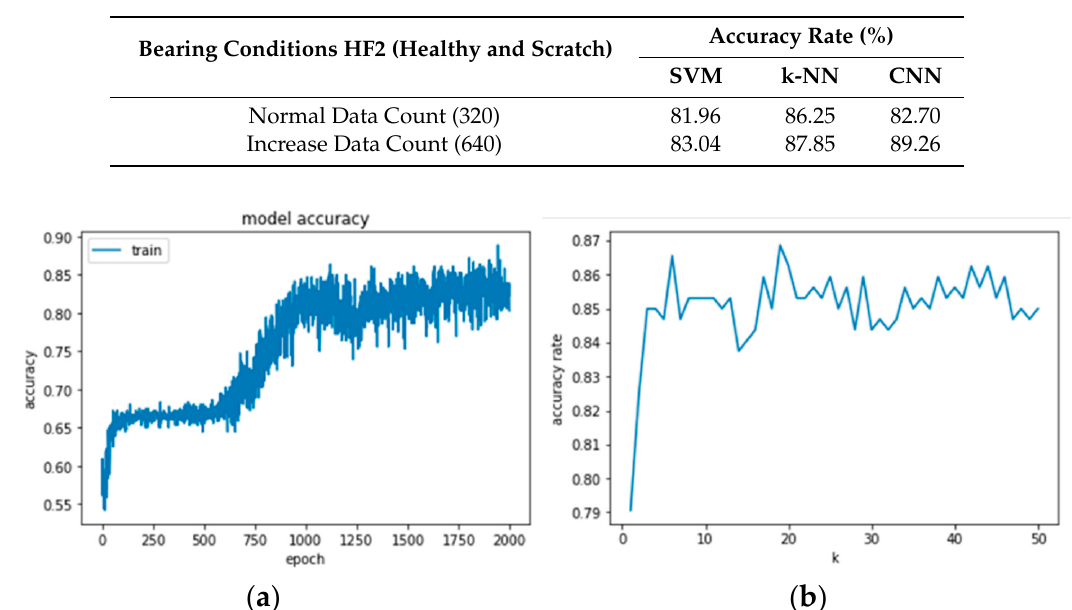
Table 4. Diagnosis result comparison.